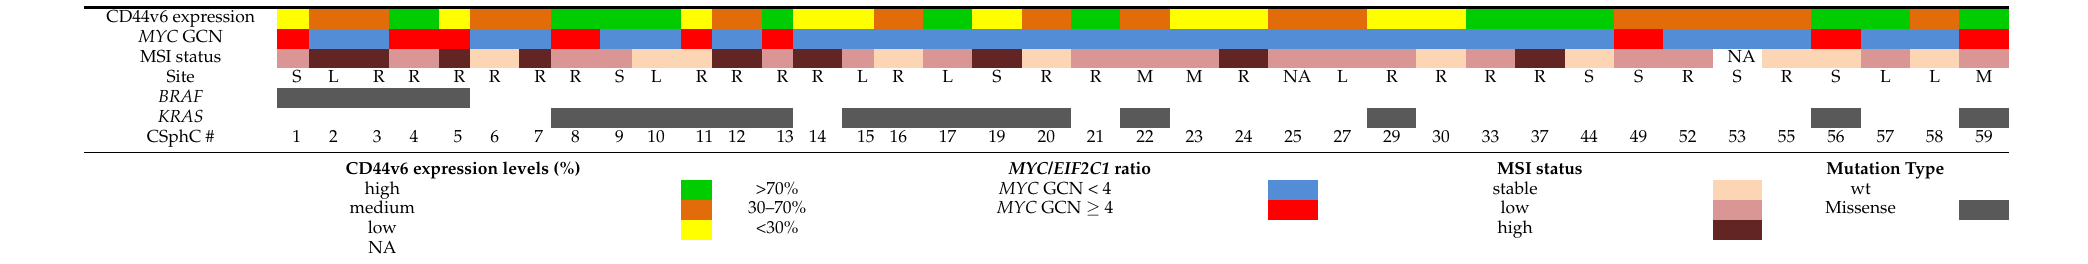
Table 1. CD44v6 expression levels, MYC copy number variation, MSI status and BRAF/KRAS mutational status of colorectal cancer sphere cells